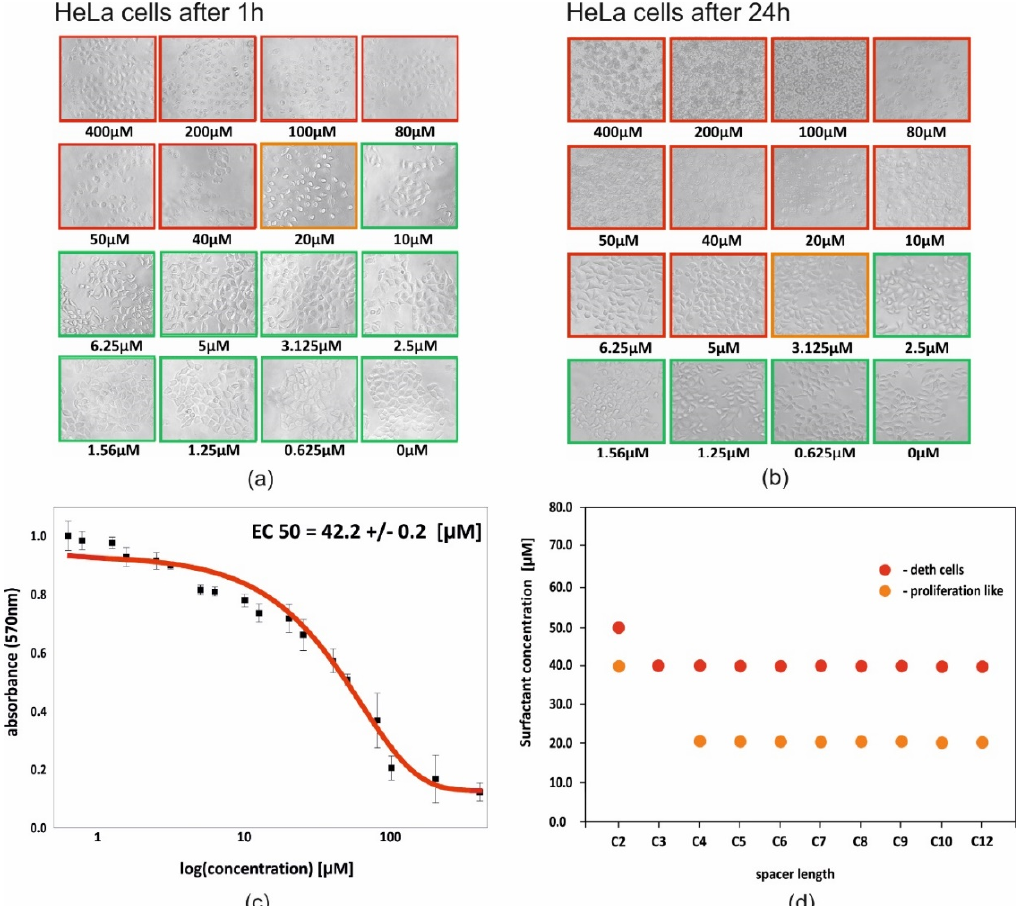
Figure 6. HeLa cells 1 h ( a ) and 24 h ( b ) after addition of C12NC6 solution in the presence of surfactants in increasing concentrations. Red squares correspond to the concentrations that cause cell death, yellow squares correspond to the cell in the proliferation stage. ( c ) MTT test result for Hela cells 1 h after addition of C12NC6 solution. ( d ) Summary of cytotoxicity test results for all tested surfactants. Red spots correspond to surfactant concentrations causing cell death and yellow spots correspond to the critical surfactant concentrations at which the cells are in the proliferation stage.